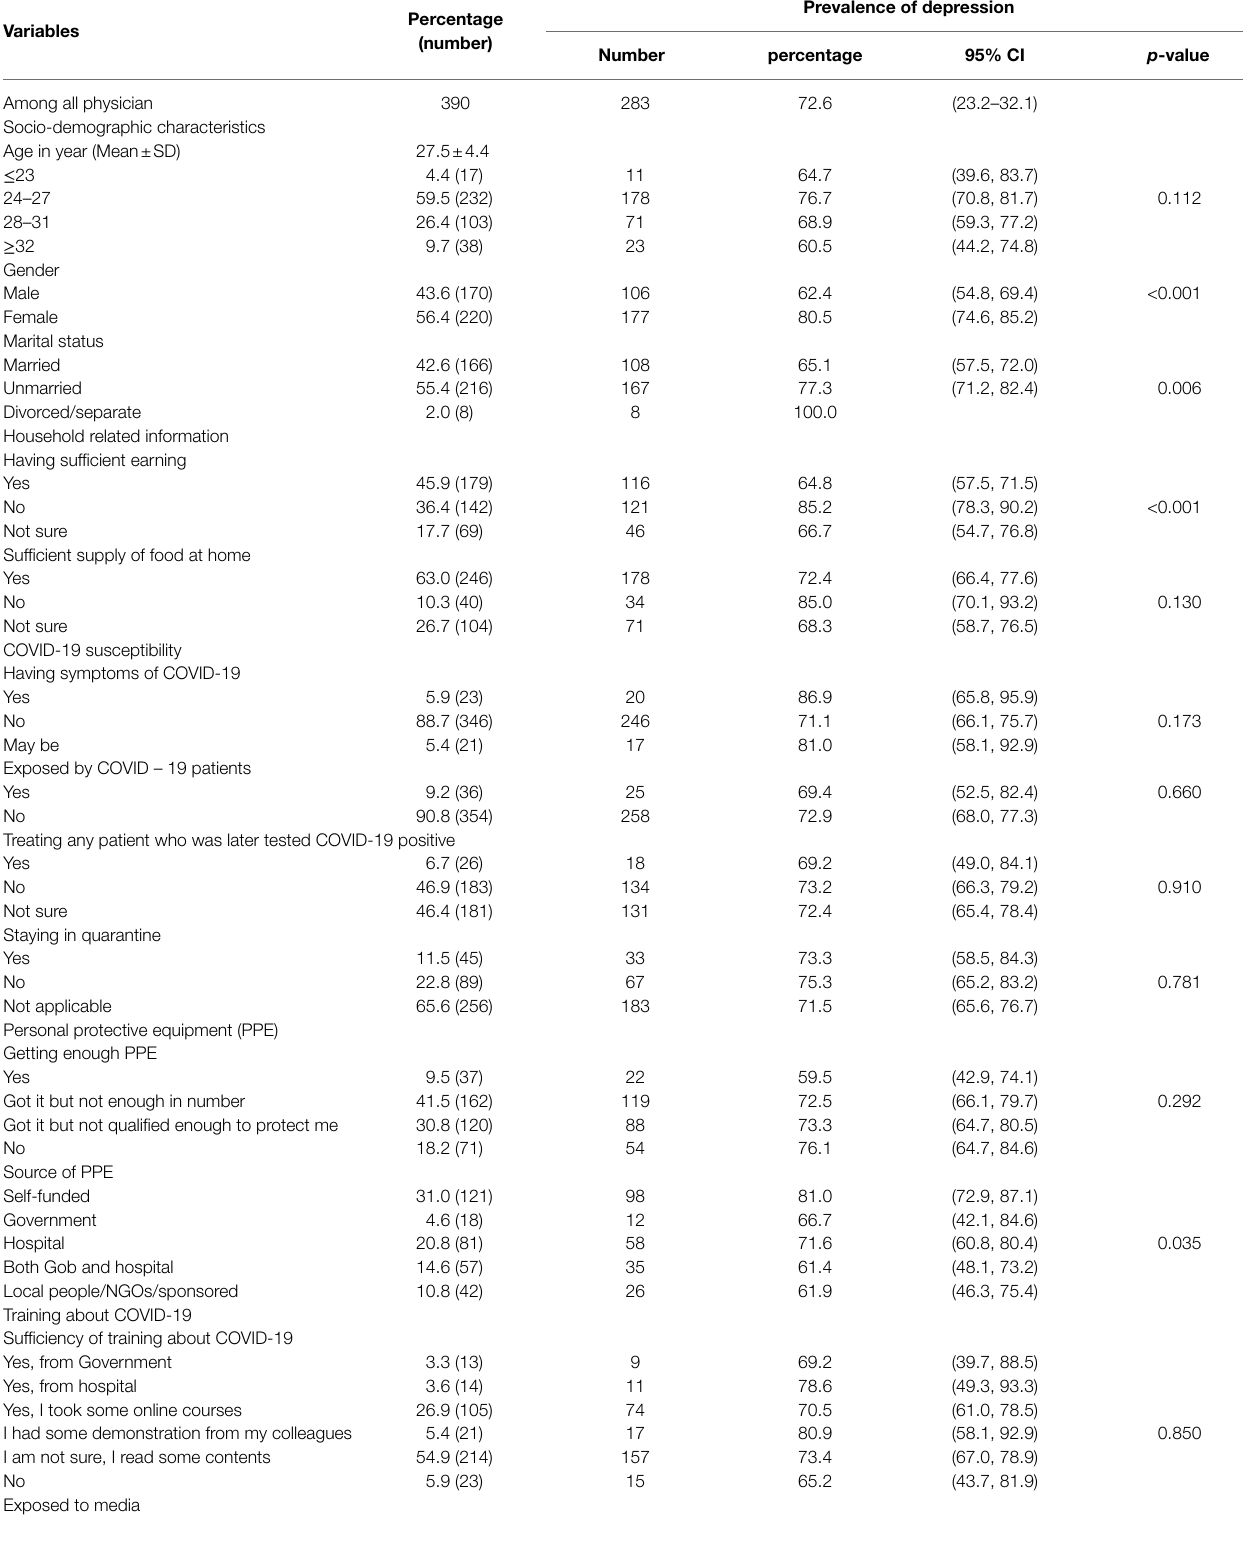
TABLE 1 | Prevalence of depression symptoms, assessed by PHQ-9, according to study participants different socio-demographic characteristics ( N = 390). Variables